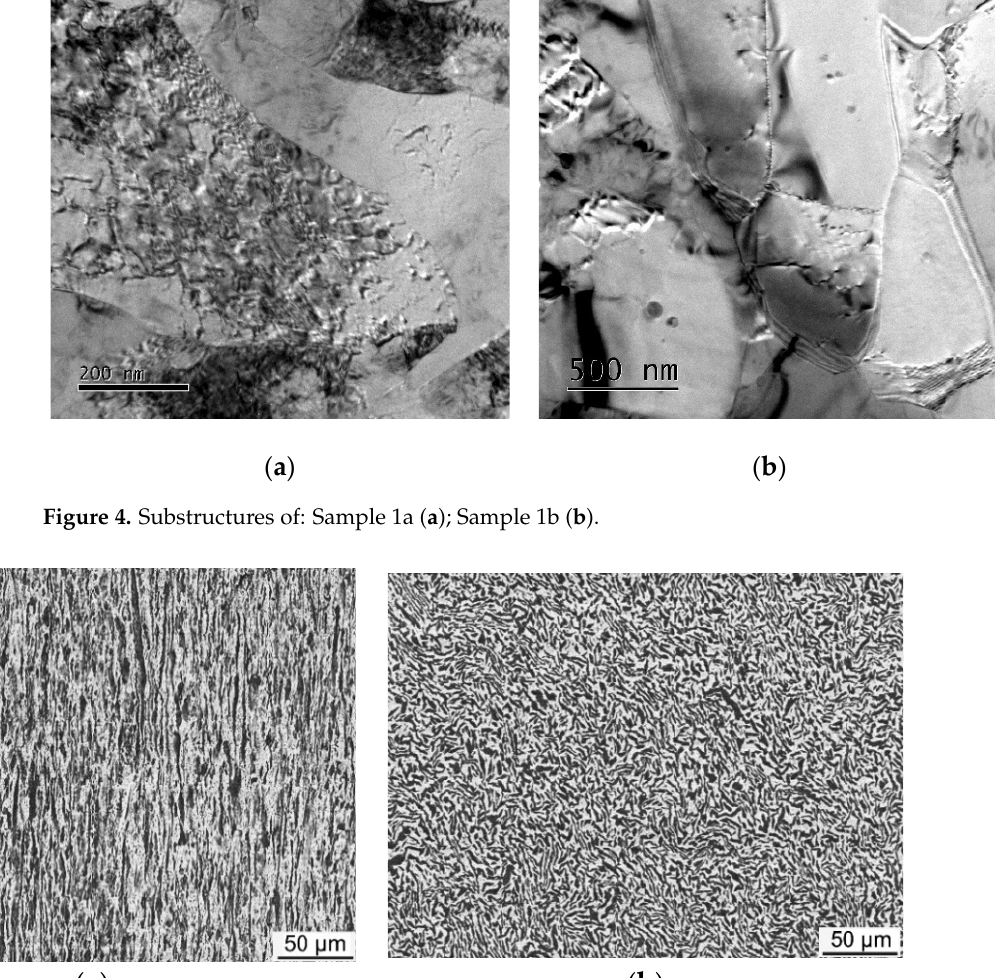
Figure 4. Substructures of: Sample 1a ( a ); Sample 1b ( b ).